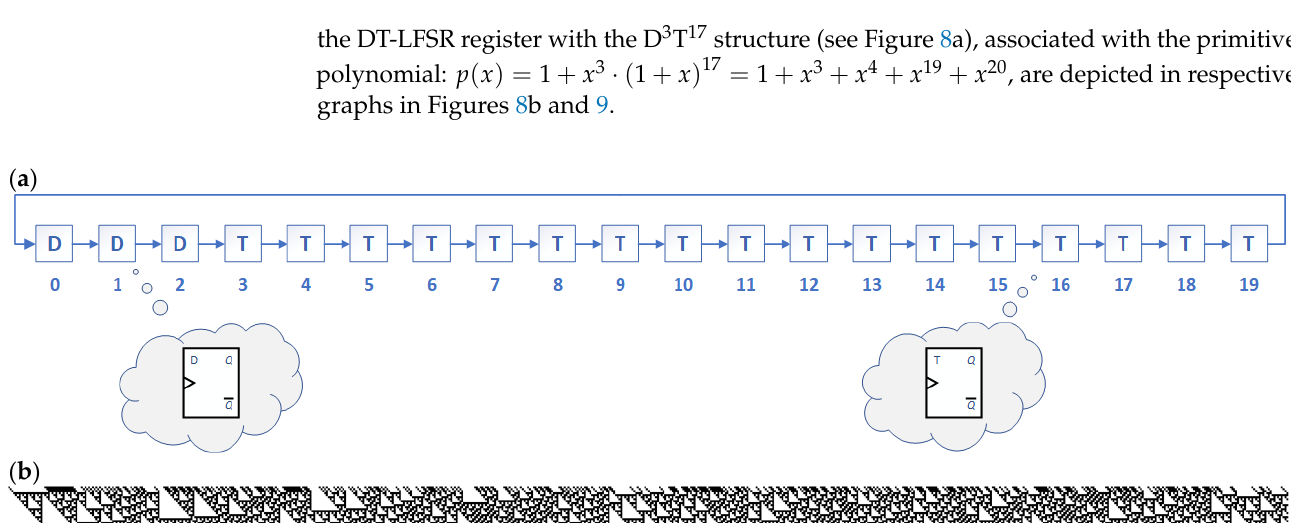
Figure 8. The DT-LFSR register with the D 3 T 17 structure and associated with the primitive polynomial p ( x ) = 1 + x 3 ( 1 + x ) 17 = 1 + x 3 + x 4 + x 19 + x 20 : ( a ) Internal structure of the register; ( b ) State–Time Diagram (STD) for that register.